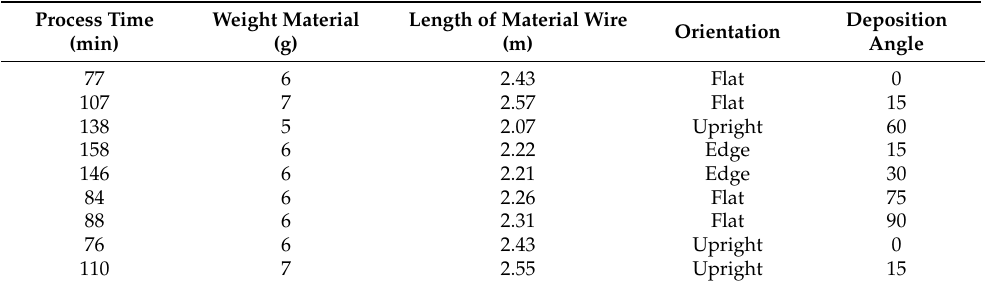
Figure 24. ( a ) CAD model with dimensions. ( b ) Micro-level CT scan of the 3D printed part [89]. (reprinted with kind permission from Elsevier). Table 5. FDM parameters and parts based data